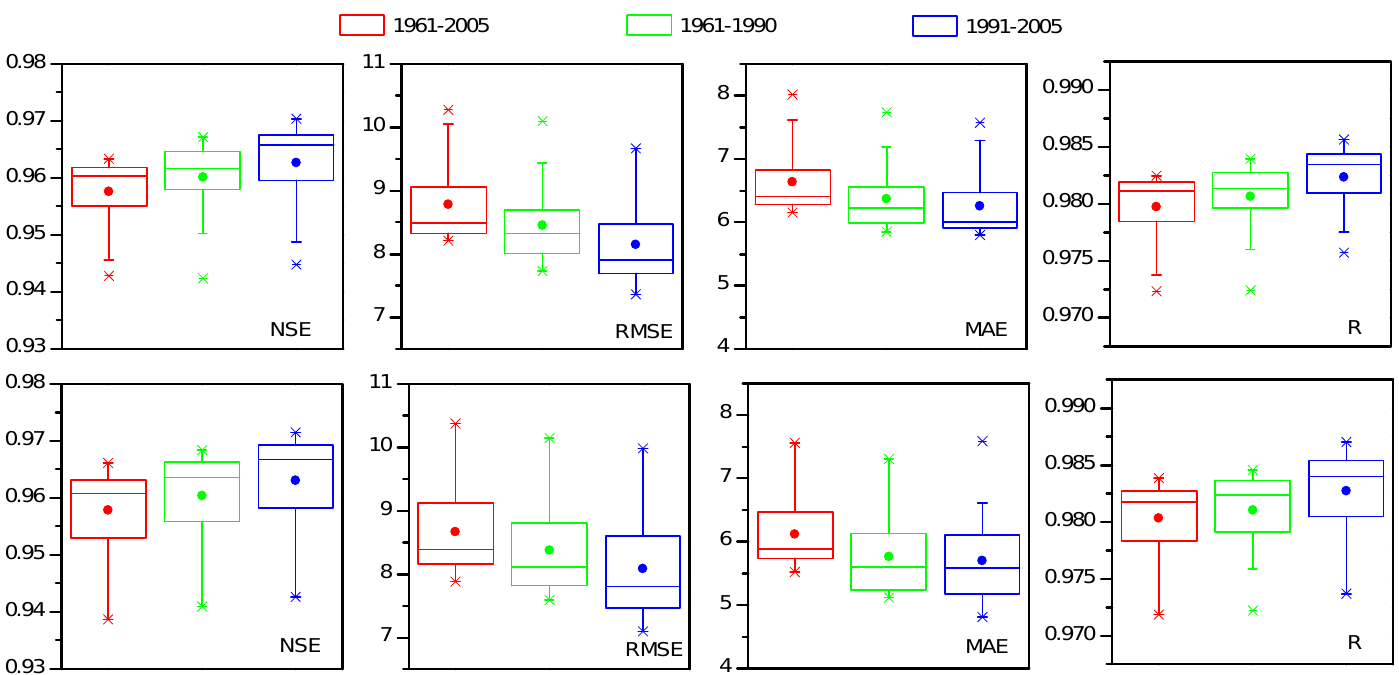
Figure 5. Boxplots for the performances of ELM (top) and SVR (bottom) models for ET 0 , calculated for different periods.